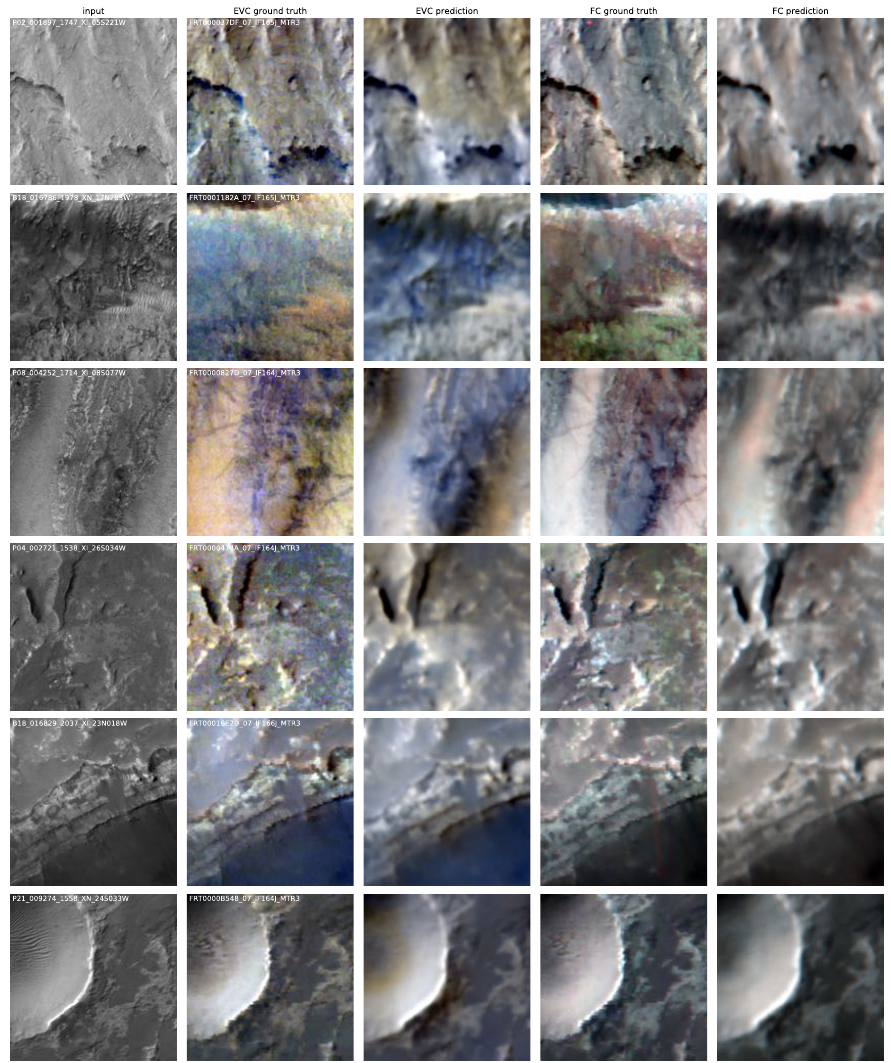
Figure 19. Appearance comparison of six test patches in the visual spectrum (EVC) and infrared (FC), predicted by two separate